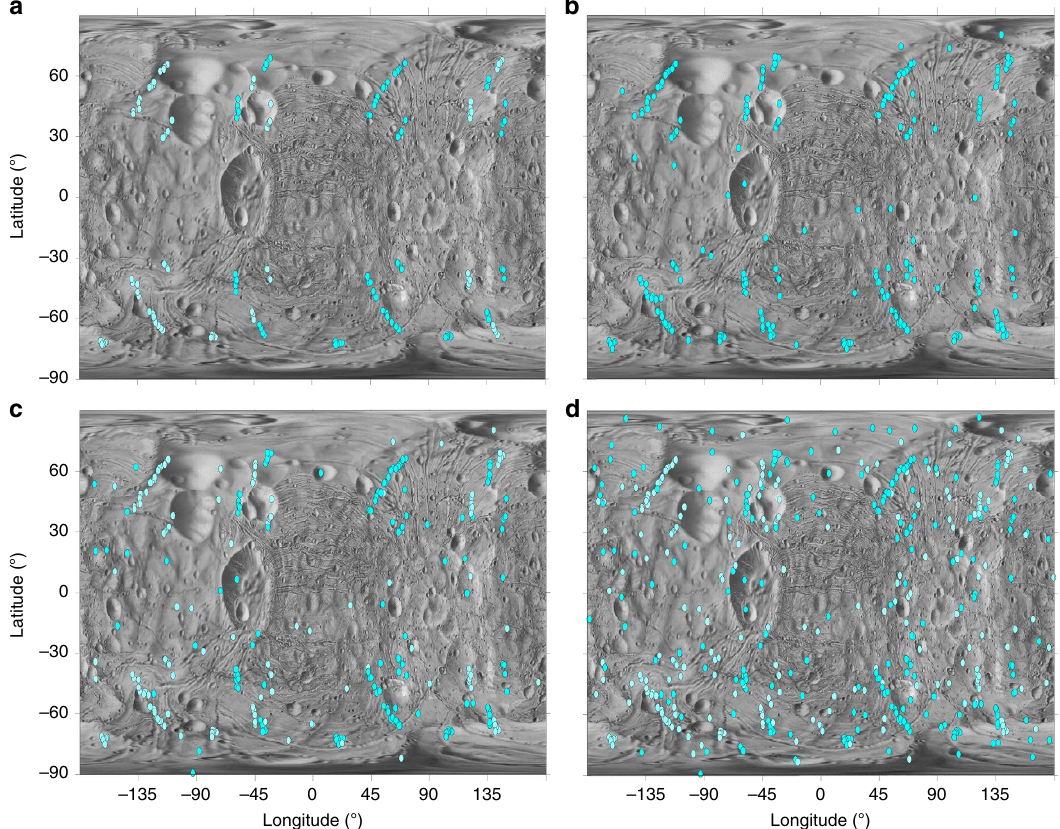
Figure 2 | The evolution of catenae with increasing velocity of ejection from Phobos. Maps show reimpact locations for sesquinary impactors with ejection velocity greater than Phobos escape velocity and lesser than ( a ) 20, ( b ) 25, ( c ) 30 and ( d ) 100ms (cid:3) 1 . Catenae-like formations are evident from particles ejected at lower velocities. As ejection velocity increases past 30ms (cid:3) 1 , reimpacts become less correlated to catenae-like structures. The source of the catenae is therefore very low-velocity particles. The primary impact location is Stickney and azimuth b A [0: p /6:2 p ].